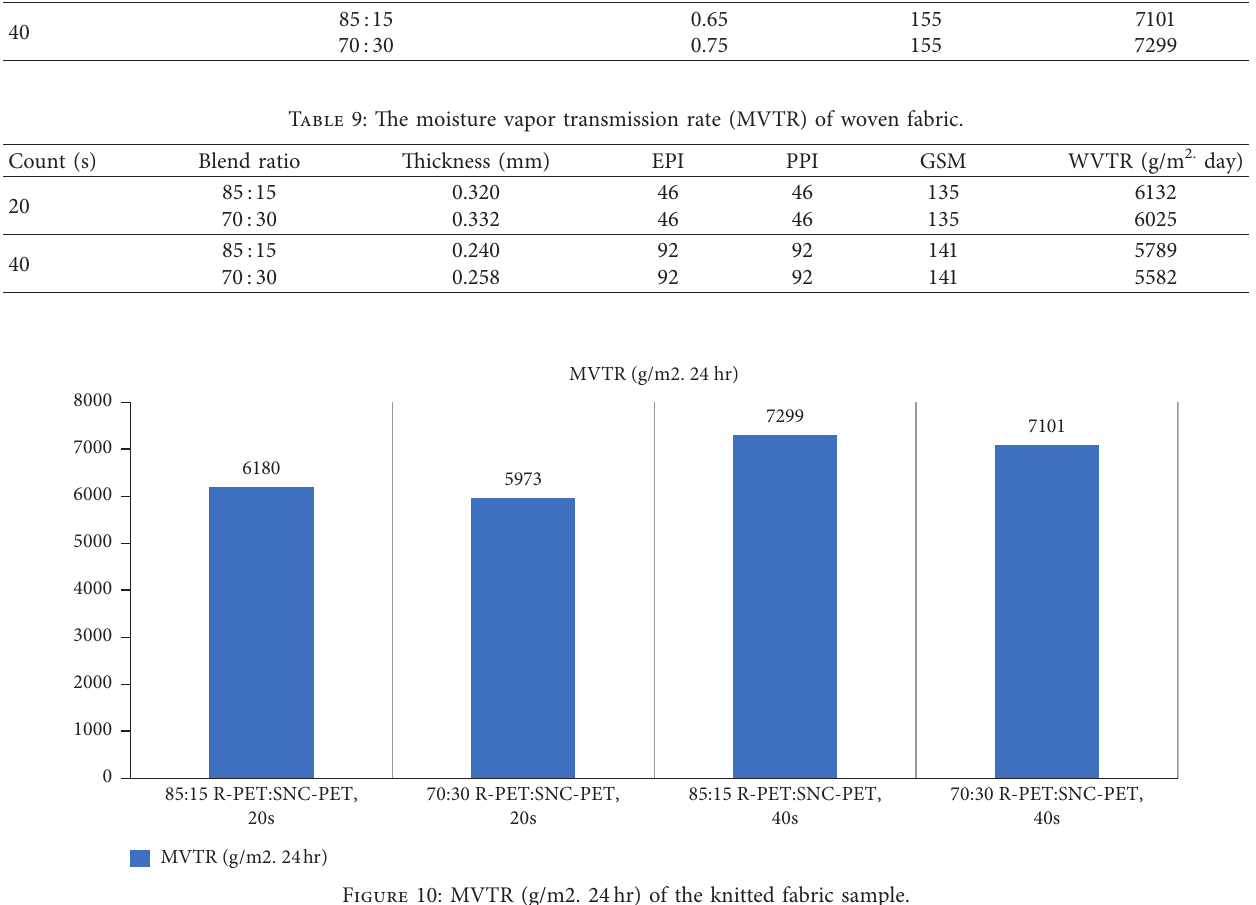
Figure 10: MVTR (g/m2. 24hr) of the knitted fabric sample.